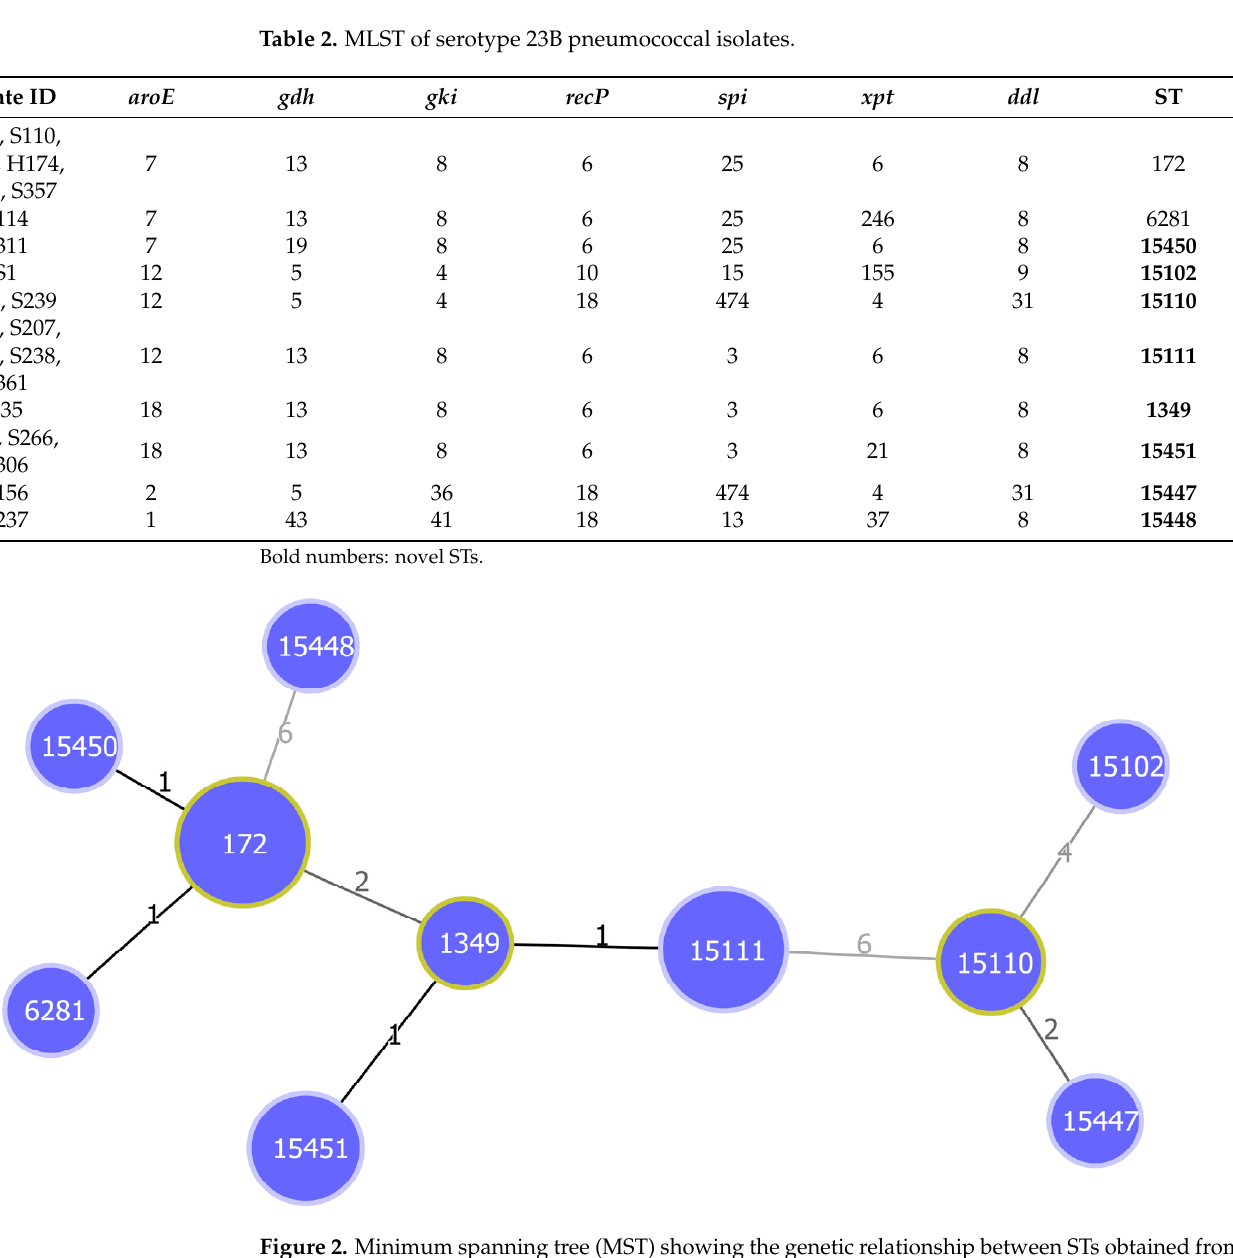
Table 2. MLST of serotype 23B pneumococcal isolates.